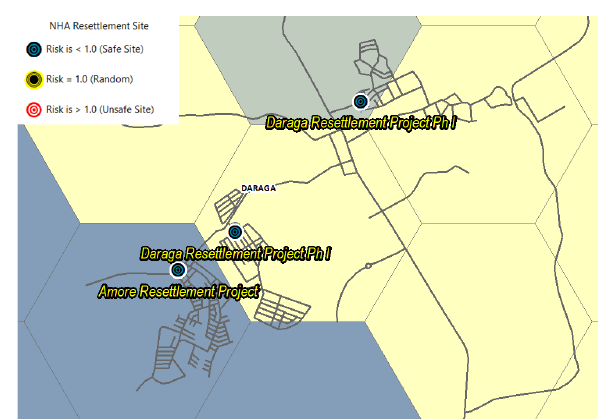
Figure 7. Safe NHA Resettlement and Relocation Sites in Daraga Figure 7 reveals the safe resettlement and housing projects of the NHA. Despite the safe relocation sites, Figure 4 reveals that some residents resettled back to Budiao. Topophilia-Exposure data binning practical characterization comfort, and origin